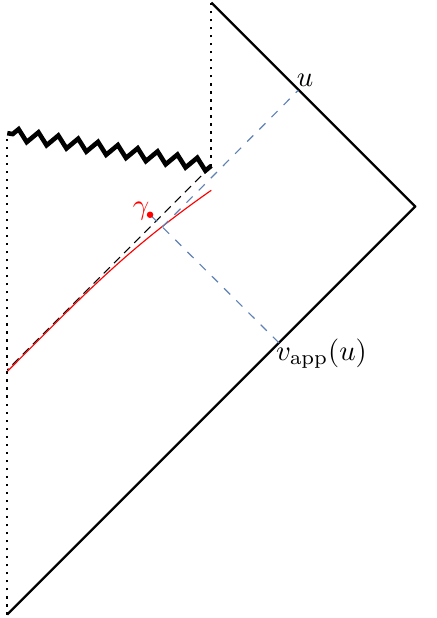
Figure 17. A sketch of the location of the nontrivial QES in an evaporating black hole. The red curve is the location of the apparent horizon, where the area is stationary to variations in the outward null direction. The function v app ( u ) is defined as the ingoing time which intersects the apparent horizon at outgoing time u , as shown by the dashed blue null lines. The QES γ for S swap ( u ) lies at ingoing time v app ( u ) , just behind the event